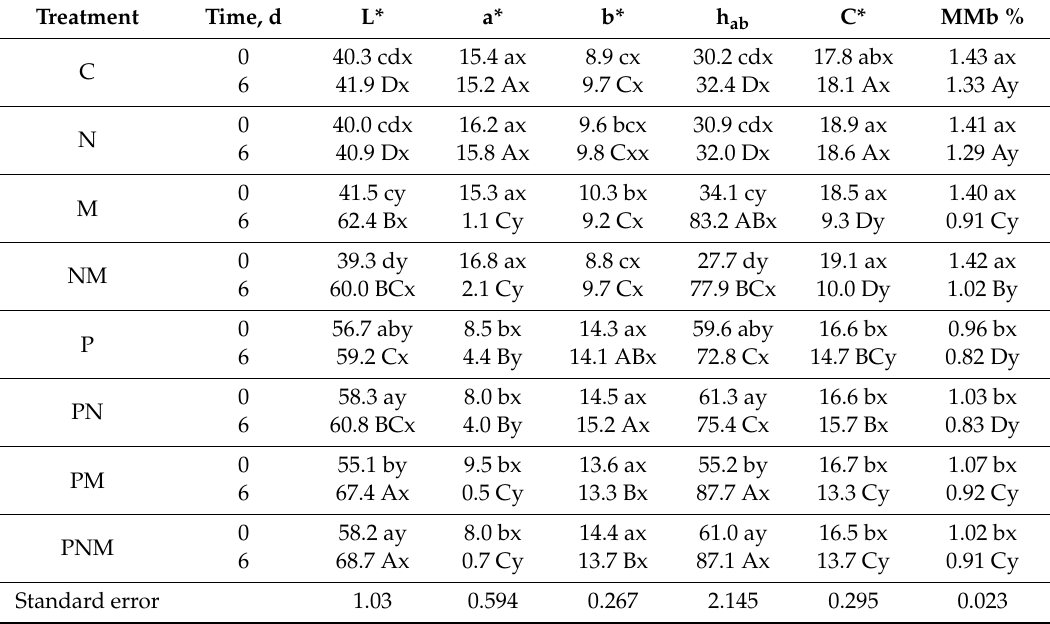
Table 2. The means and standard errors for beef color variables as a function of the studied factors (pressure application, packaging type, marinate immersion and storage time). Treatment Time, d L* a* b*